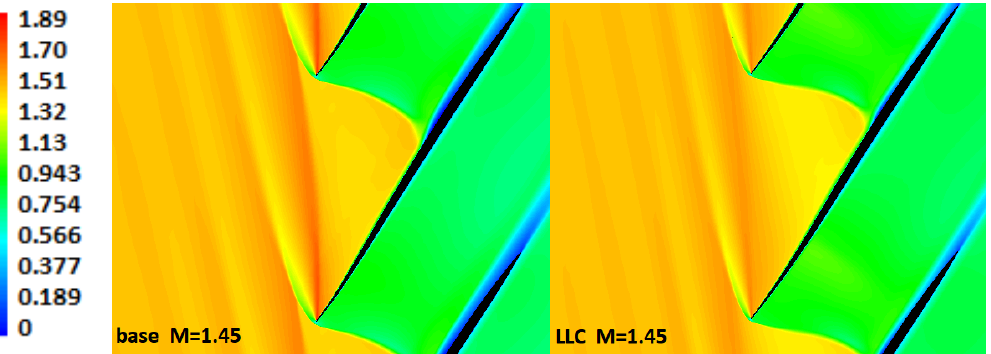
Figure 12. Mach contours of profiles with LLC at Mach 1.45.